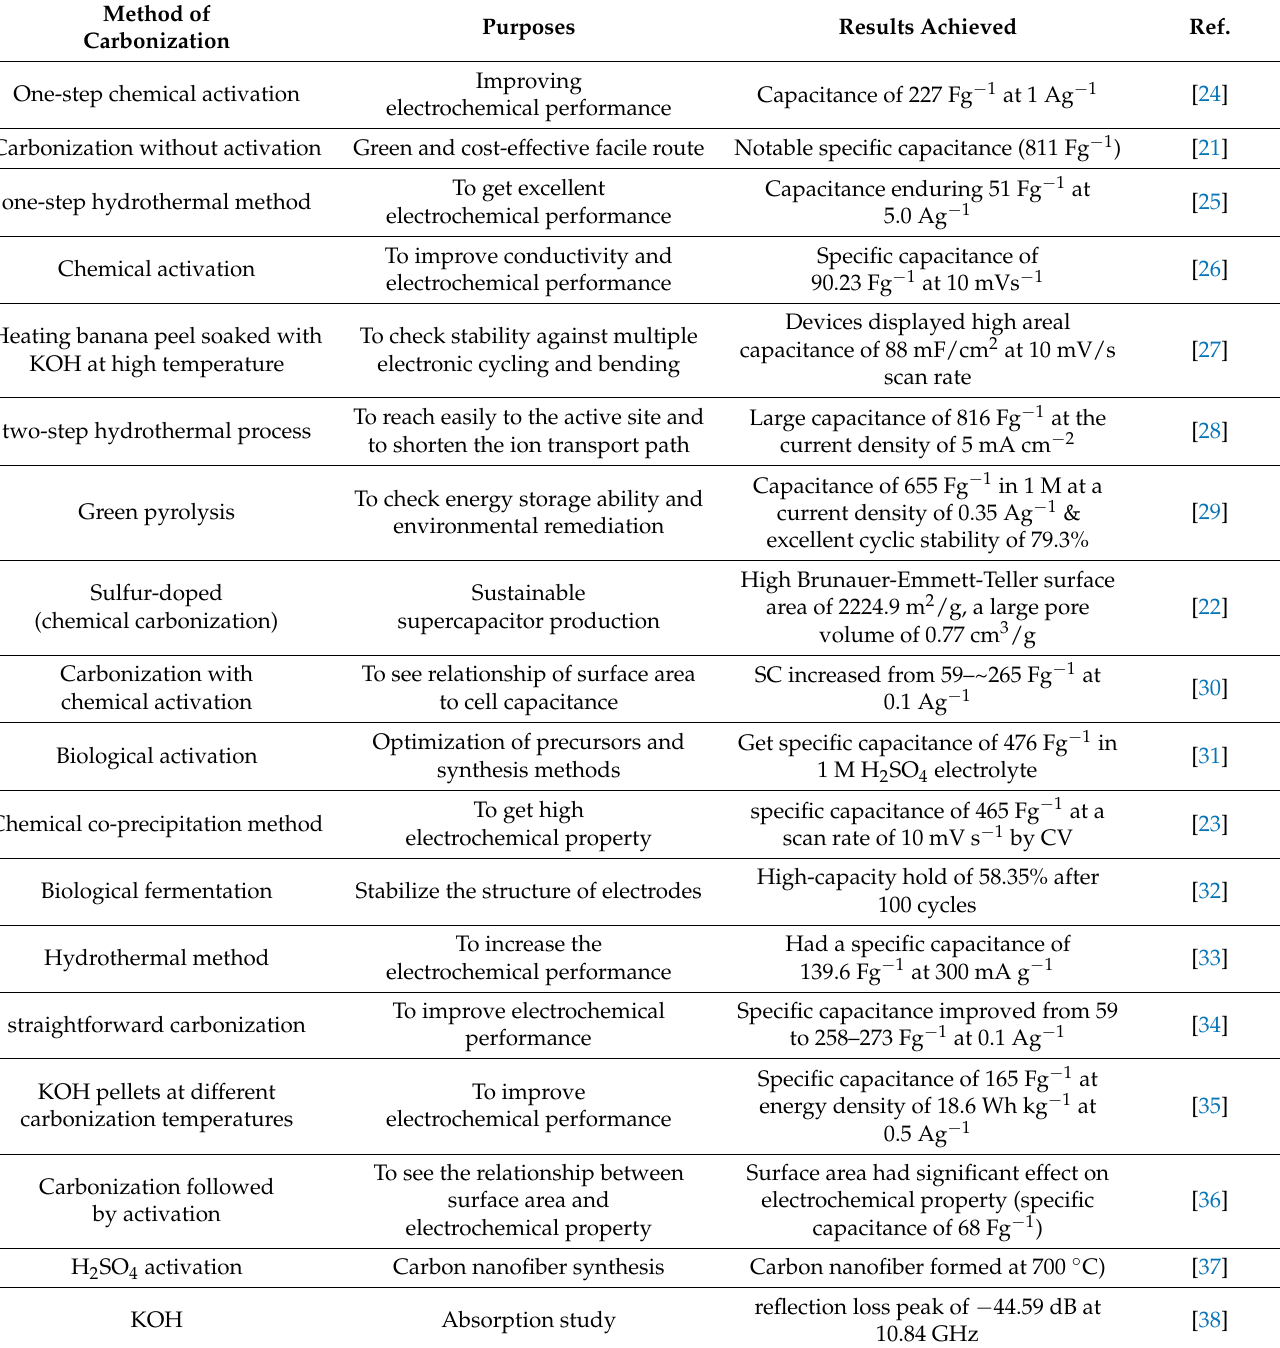
Table 1. Summary of carbonized supercapacitor (SC) manufacturing based on banana